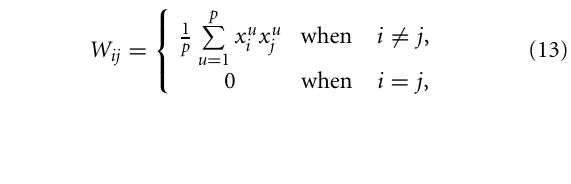
calculates the membrane potential v which is received by the silicon synapse unit to generate the postsynaptic input I s . An accumulator unit in an SNNM calculates the weighted sum of I s and added with the bias constant I 0 gives stimulus current to the DSSN unit in the same